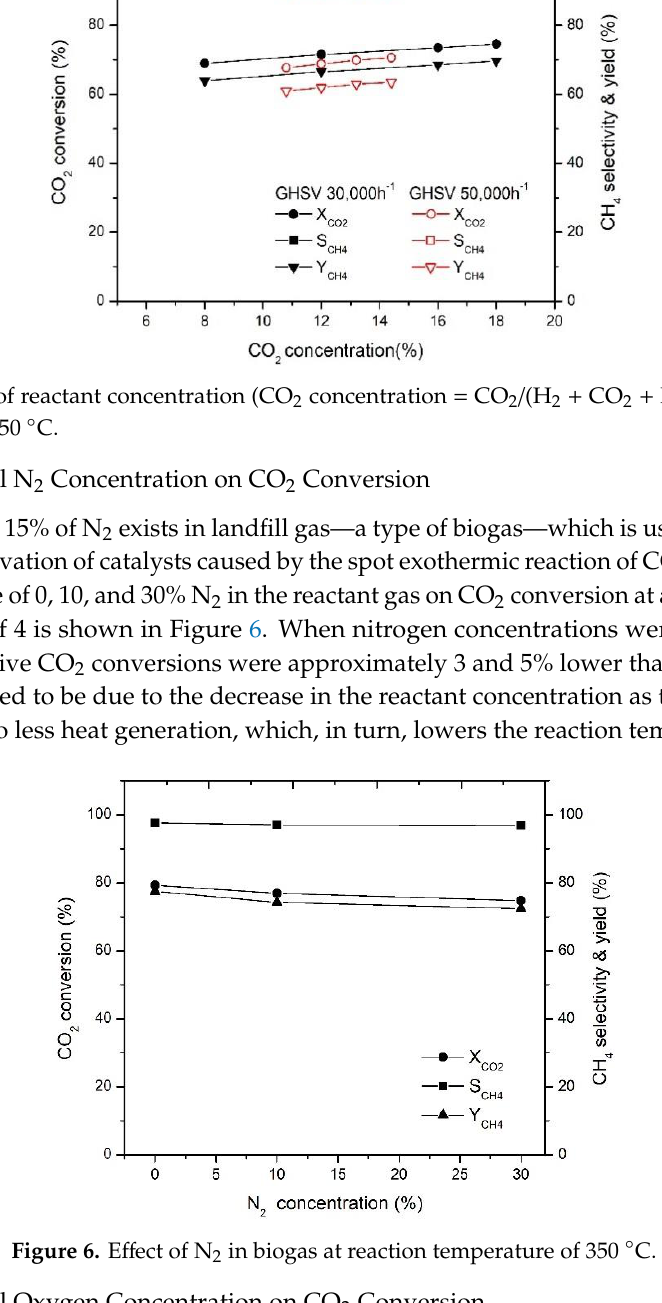
Figure 6. Effect of N 2 in biogas at reaction temperature of 350 °C.